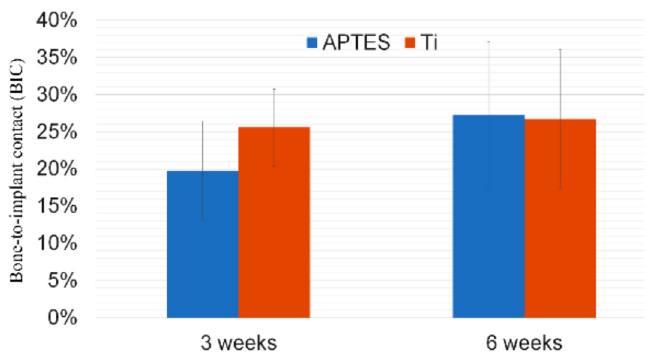
Figure 5. Bone-to-implant contact (BIC) values determined for the Ti and APTES-coated titanium implants after 3 weeks and 6 weeks of